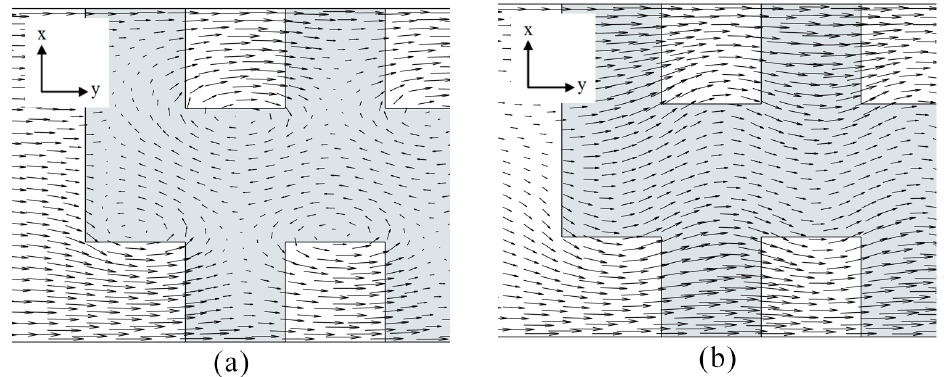
Figure 7. Velocity vectors on x - y plane: ( a ) z / H c = 0.2 and ( b ) z / H c = 0.45.